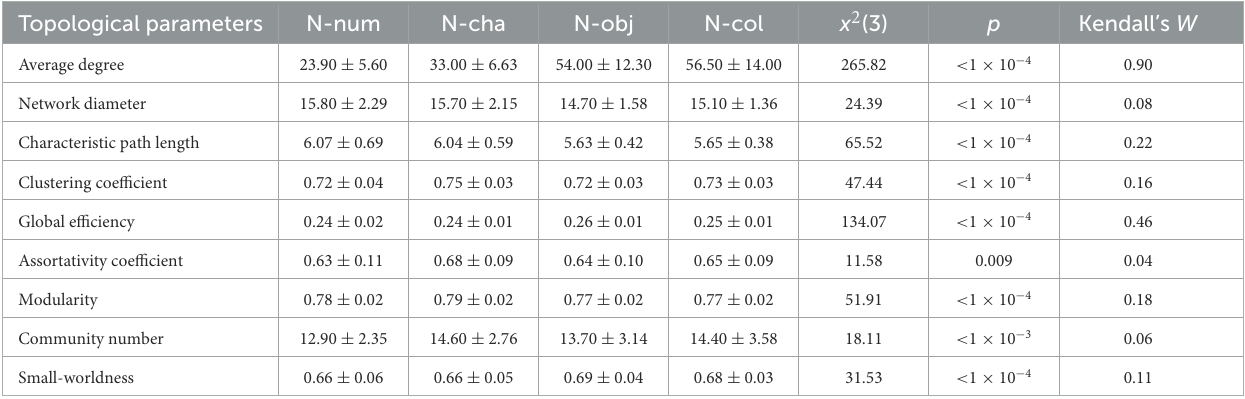
TABLE 1 Difference between different RAN tasks for each of the topological parameters (M ± SD).